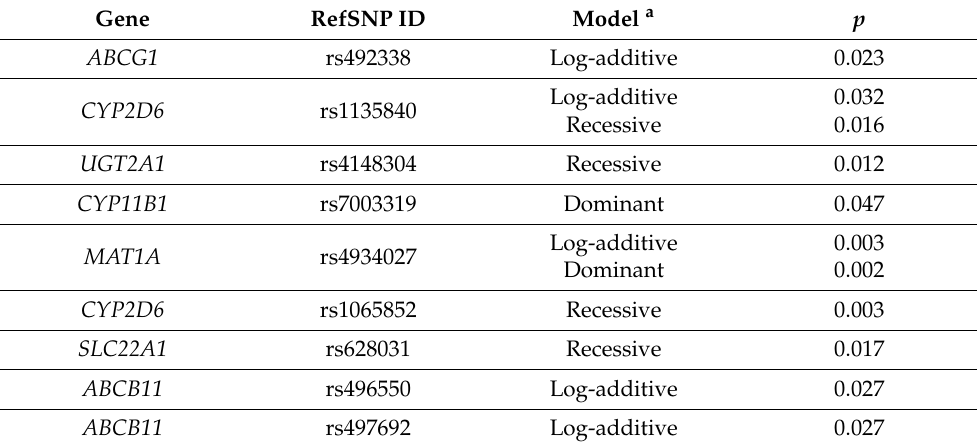
Table 4. gSNVs significantly associated ( p < 0.05) with MMR achievement in the permutation test (performed with a total of 10,000